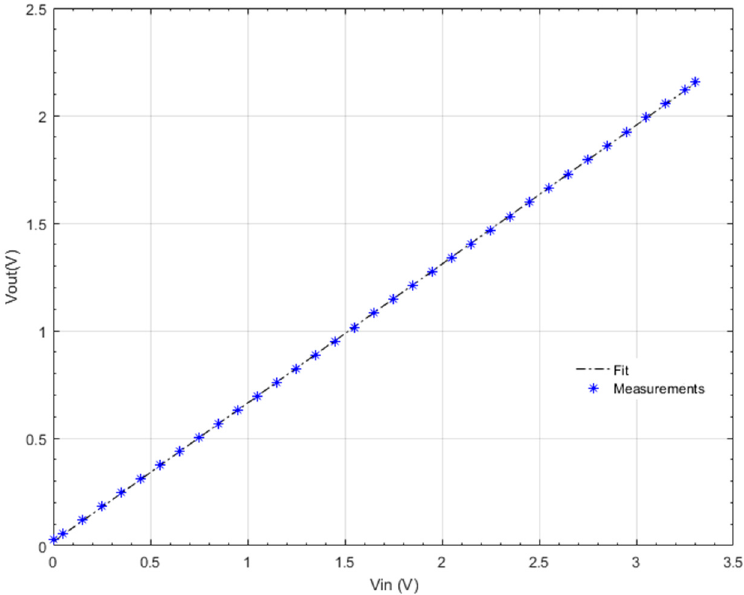
Figure 14. Σ∆ -ADC output Figure 14. ΣΔ -ADC output linearity.